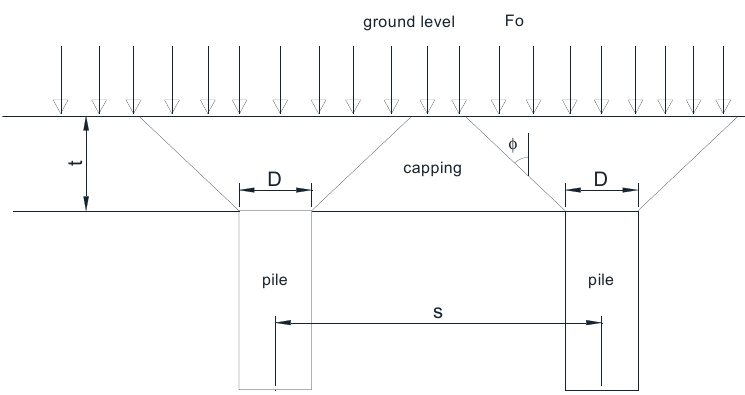
Figure 7. Model for load distribution through the capping beam.